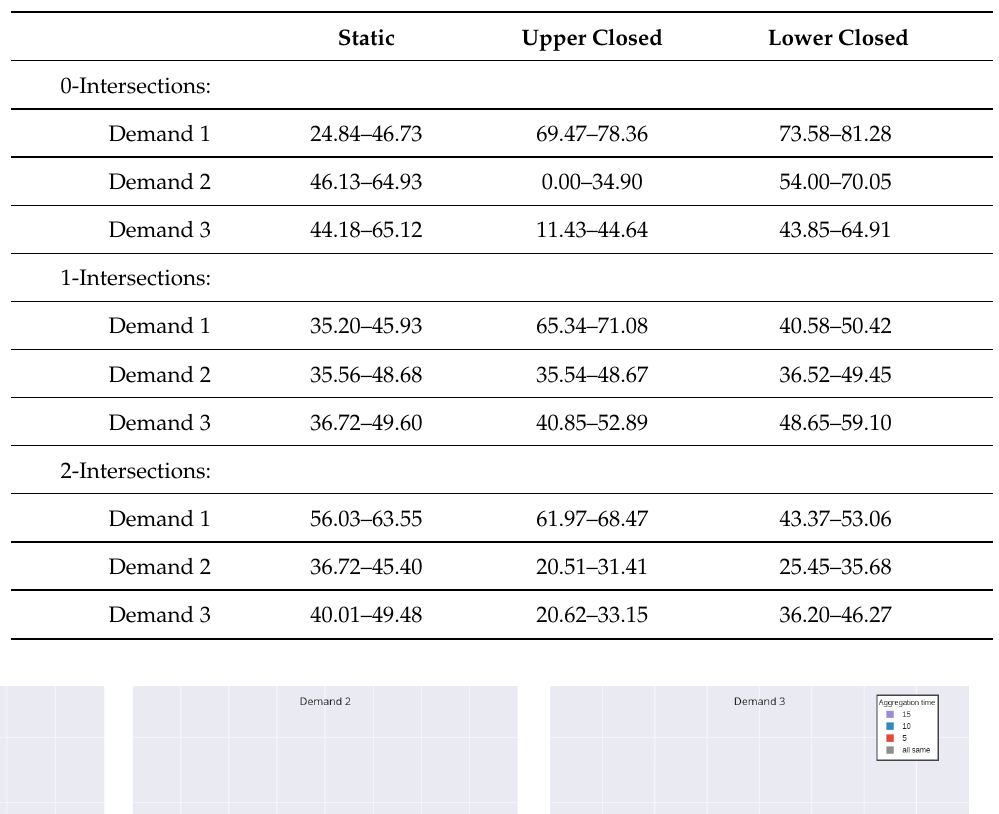
Table 3. The occupancy algorithm’s overall travel-time decrease (in percent), when compared to the base cases with 15 min, 10 min, and 5 min as aggregation times and the optimal transition times for each model. This means that the lowest decrease in travel time comes from the 15 min aggregation time, and the largest decrease in travel times comes from the 5 min aggregation time.